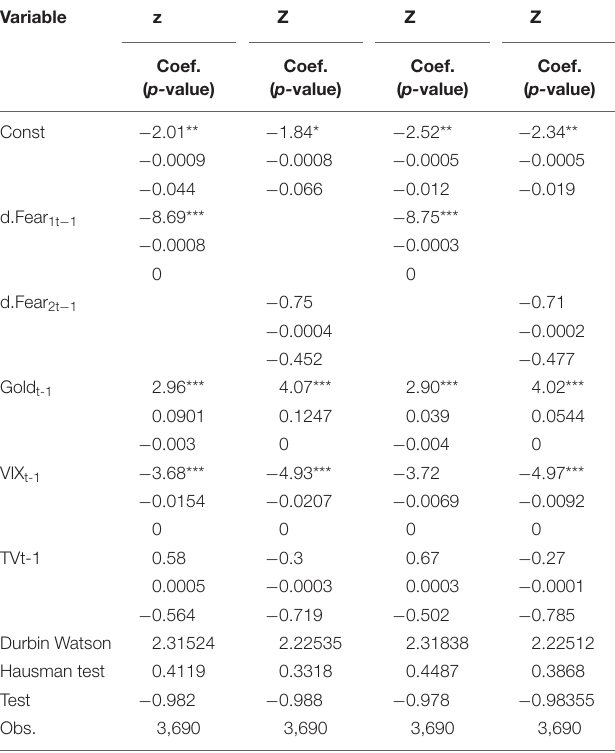
TABLE 6 | The predictive capacity of the COVID-induced public fear of the European stock markets 24 return.